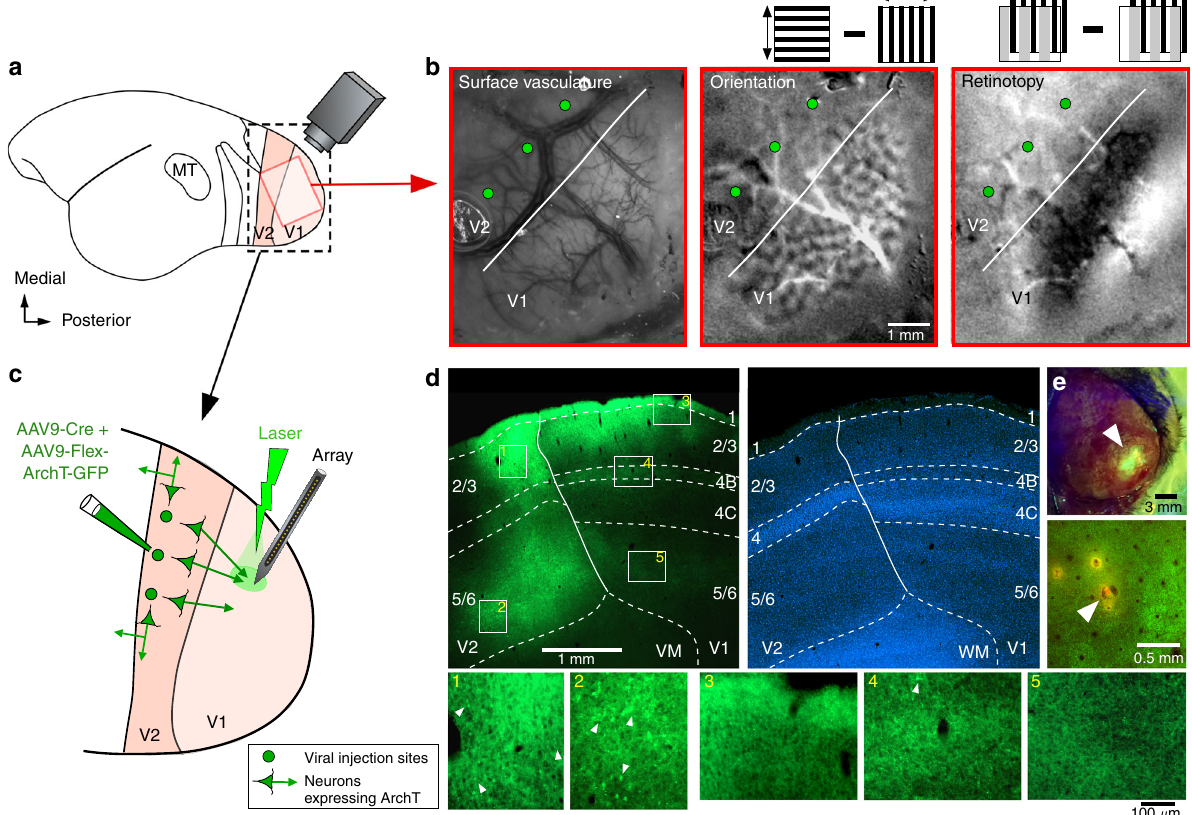
Fig. 1 Optogenetic inactivation of V2 feedback terminals: experimental design and ArchT-GFP expression in V2 feedback terminals. a Schematics of the marmoset brain. Red box: approximate location of the optically imaged region in b . Black box: V1 and V2 region shown enlarged in c . b Optical imaging identi fi es V1/V2 border (white line). Left panel: cortical surface vasculature imaged under green light, used as reference to position pipettes for viral injections (green dots). Middle panel: orientation map generated by subtracting responses to 0° and 90° gratings (as shown in inset). V2 can be identi fi ed by larger orientation domains compared to V1. Right panel: retinotopic map generated by subtracting responses to 90° oriented gratings occupying complementary and adjacent strips (1° in width) of visual space (as shown in inset above; see Methods). The V1/V2 border can be identi fi ed by the presence of stripes in V1, running approximately parallel to the V1/V2 border, which are absent in V2 (as the grating parameters were optimized for V1, but not V2, cell; see Methods). c Schematics of the inactivation paradigm: multiple viral injections were targeted to V2, array recordings and laser photostimulation to V1. d ArchT-GFP expression in V1 and V2. Top left: sagittal section through V1 and V2, viewed under GFP fl uorescence, showing two injection sites con fi ned to V2, and resulting expression of ArchT-GFP in the axon terminals of V2 feedback neurons within V1 layers 1 – 3, 4B and 5/6 (typical feedback laminar termination pattern 32,33 ). This tissue section was located near the lateralmost aspect of the hemisphere, therefore the infragranular layers are elongated due to the lateral folding-over of the cortical sheet. Solid contour: V1/V2 border. Dashed contours: laminar borders delineated on the same section counterstained with DAPI (top right). Bottom panels 1 – 5: higher magni fi cation of label inside the white boxes numbered 1-5 in the top left panel. Panels 1 – 2 show multiple clusters of labeled somata (e.g., arrowheads) at the V2 injection sites; instead, there is only one labeled soma (arrowhead) in panel 4, and none in panels 3,5. e Top panel: GFP excitation (arrowhead) through the intact thinned skull, approximately two months after viral injection. Bottom panel: Tangential section through V1 showing the location of a DiI-coated electrode penetration (arrowhead) amid ArchT-GFP- expressing feedback axon terminals (green fl